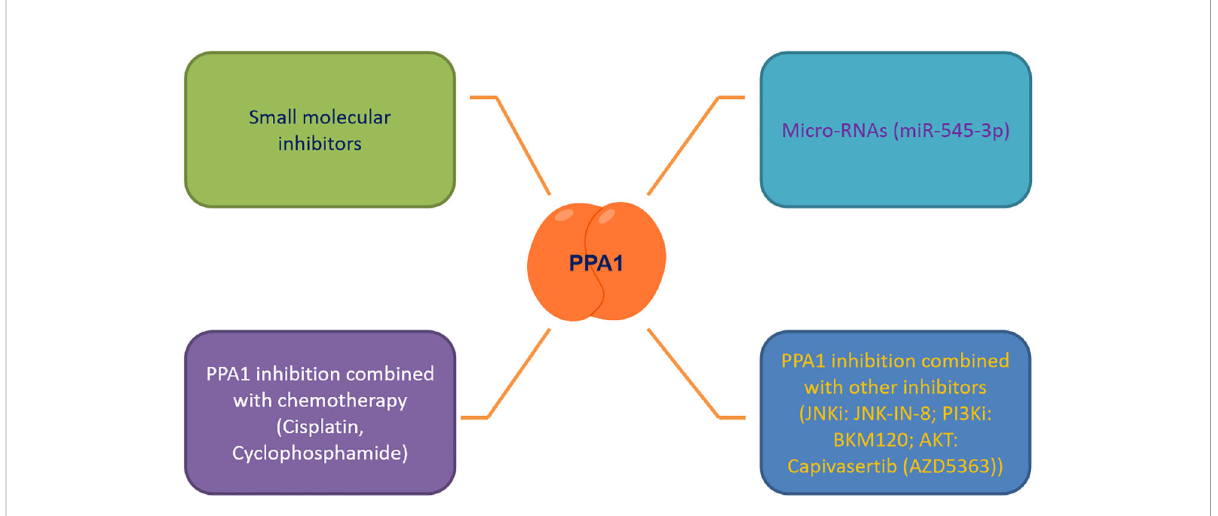
FIGURE 3 Targeting PPA1 to develop future therapeutic